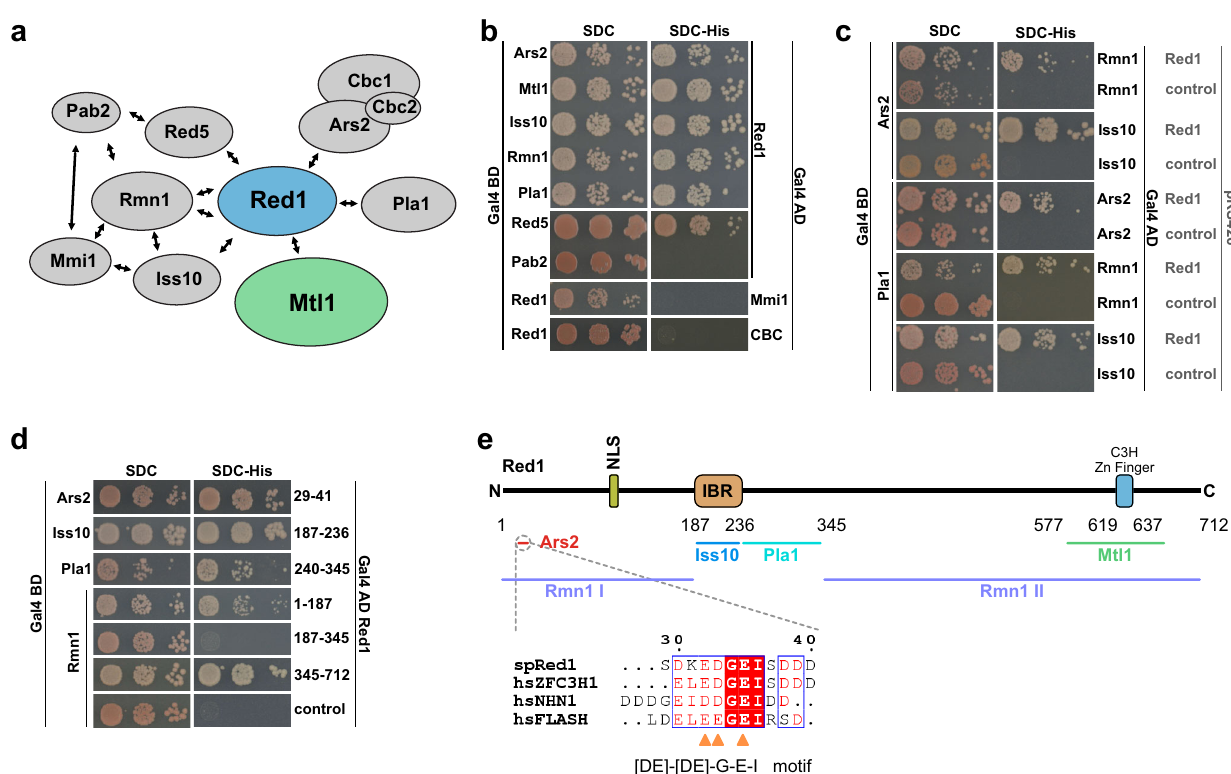
Fig. 1 Detailed analysis of MTREC submodule interactions. a Organization of the MTREC complex. The Mtl1 – Red1 core interacts via Red1 with all submodules, comprising Cbc1 – Cbc2 – Ars2, Iss10 – Mmi1, Red5 – Pab2 – Rmn1, and Pla1. Arrows indicate all direct interactions identi fi ed in this study (see b and c ). b Yeast two-hybrid analysis identi fi ed direct interactions between Red1 and Ars2, Mtl1, Iss10, Rmn1, Pla1, and Red5. For the CBC complex, Cbc1 is fused to Gal4 AD and an untagged version of Cbc2 is expressed from a third plasmid, pRS426. Gal4 BD, Gal4 DNA-binding domain; Gal4 AD, Gal4 activation domain; SDC-Leu-Trp (SDC) and SDC-Leu-Trp-His (SDC-His). Auto-activation controls are shown in Supplementary Fig. 1a. c Yeast three-hybrid analysis shows that interactions between Ars2-Rmn1, Ars2-Iss10, Pla1-Ars2, Pla1-Rmn1, and Pla1-Iss10 are bridged by Red1. SDC-Leu-Trp-Ura (SDC) and SDC-Leu- Trp-Ura-His (SDC-His). d Yeast two-hybrid analysis shows that the different submodules interact with various Red1 truncation variants. e Scheme of the interacting regions of the MTREC submodules with Red1 analyzed in d . The inset shows a multiple sequence alignment of the Ars2-binding region present in sp Red1, hs ZFC3H1, hs NHN1, and hs FLASH. IBR Iss10-binding region, NLS nuclear localization